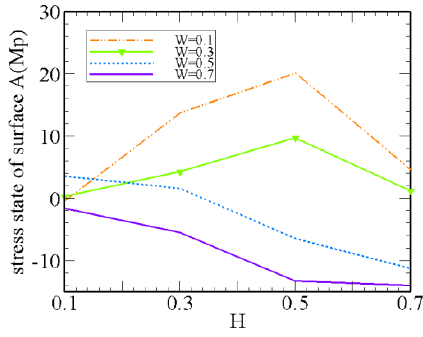
Figure 9. State of stress changes in texturing depth.